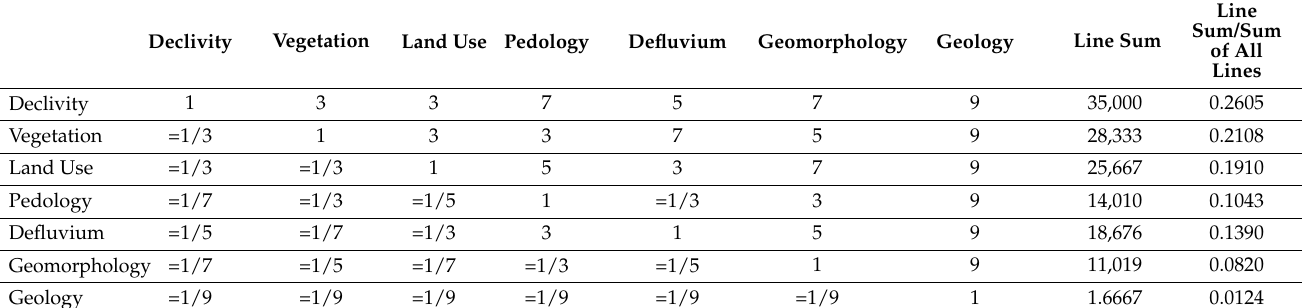
Table 3. Saaty scale considering landslides in the district of M ã e Luiza, Natal,